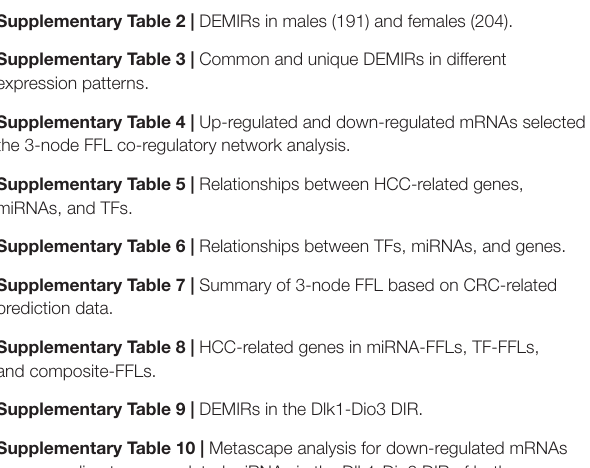
Supplementary Table 9 | DEMIRs in the Dlk1-Dio3